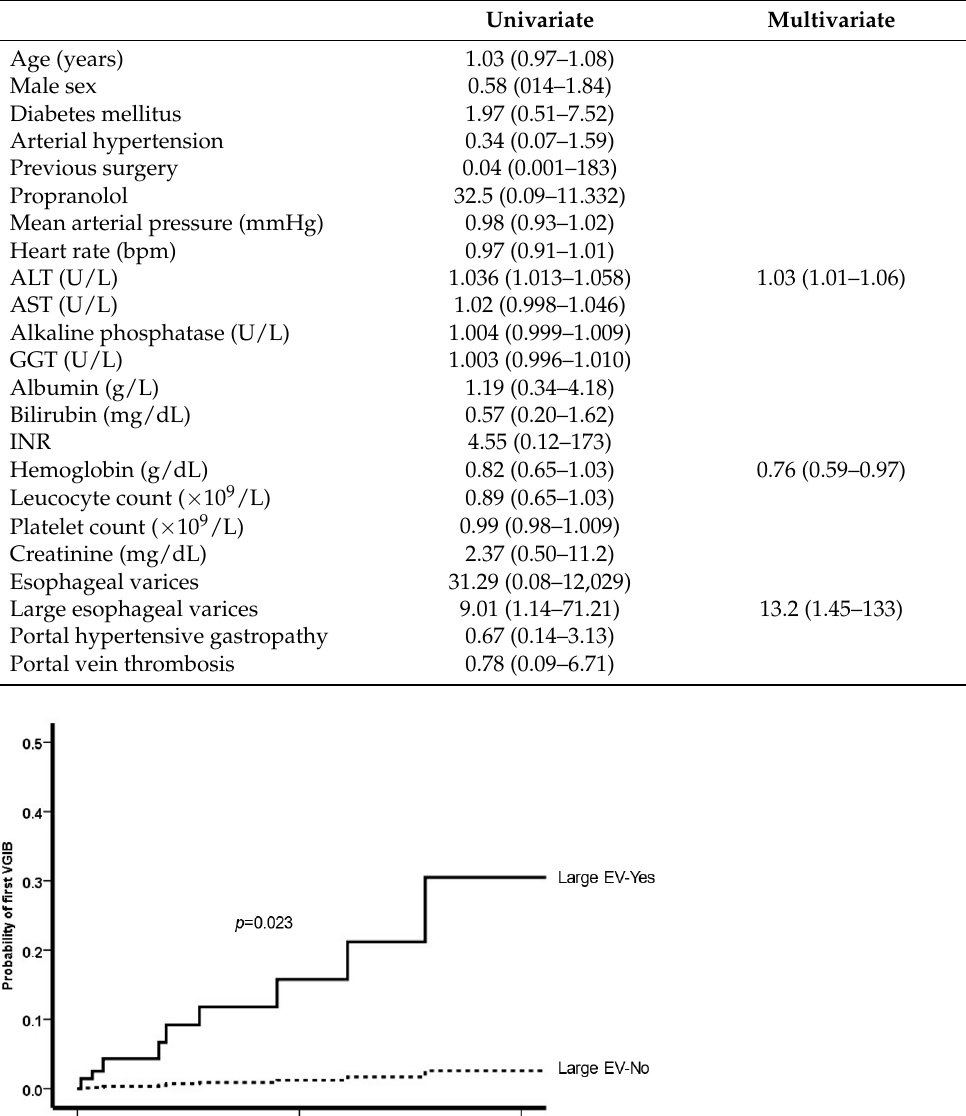
Table 2. Factors associated with new-onset bleeding (n = 56).